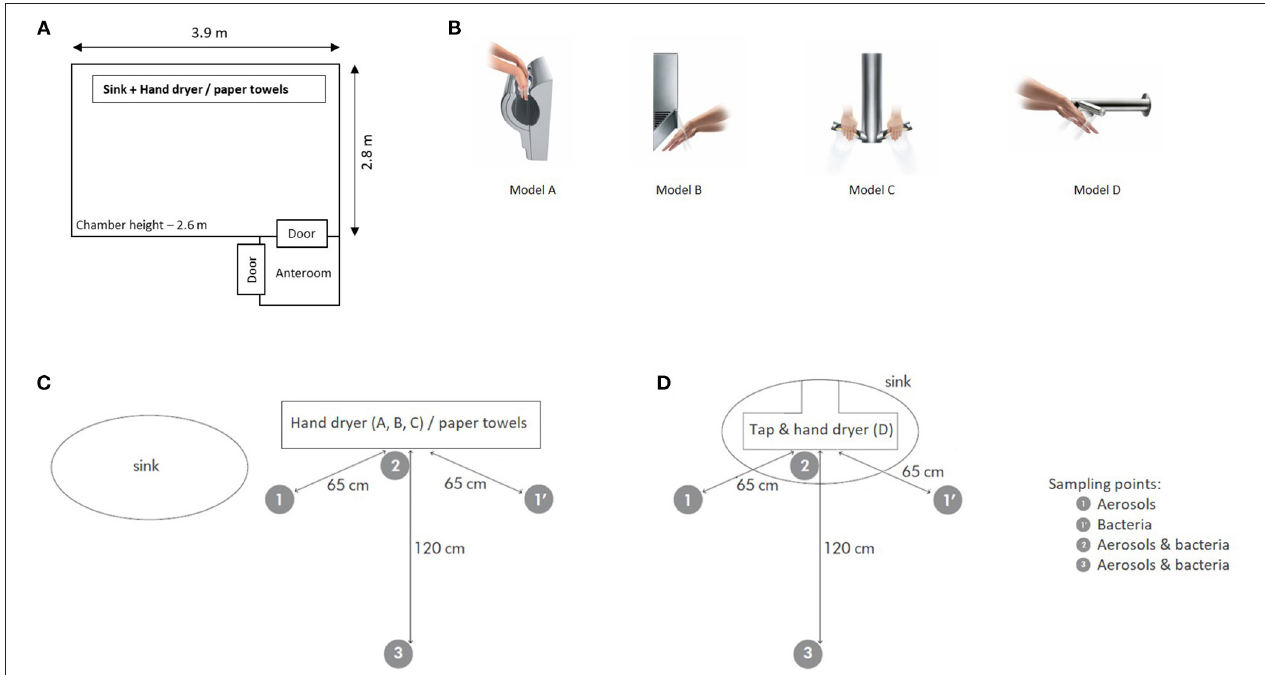
FIGURE 1 | Diagrams representing (A) experimental chamber and (B) different models of jet hand dryers used in this study and hands position for drying. Sampling locations for (C) jet air dryer model A, B and C and paper towels and for (D) jet air dryer model D. Samplers are represented by the gray circle, with aerosol/particles counts samplers at locations 1, 2, and 3 and samplers for bacteria counts locations at 1’, 2, and 3.